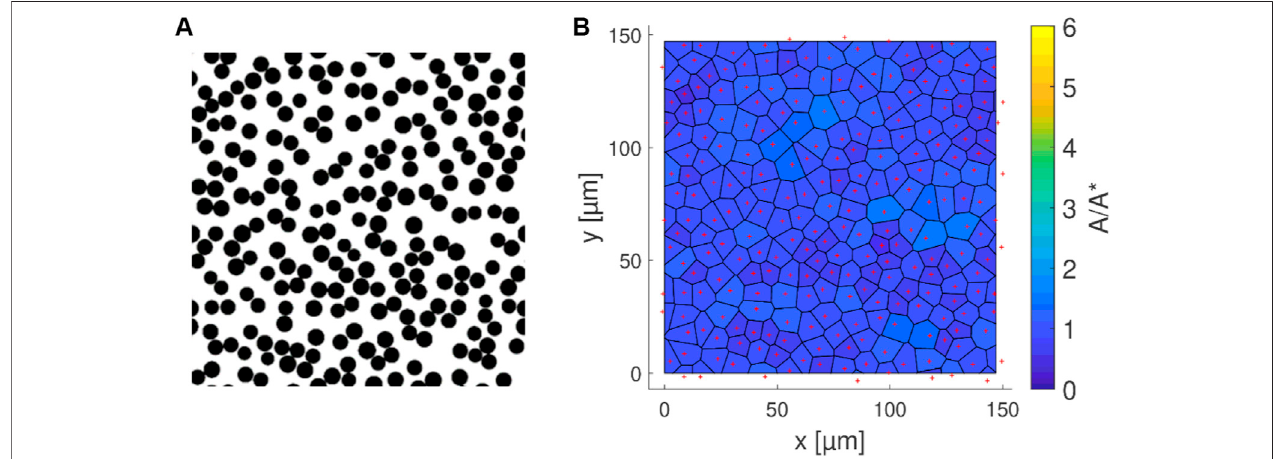
FIGURE 7 | Example of an SVE with 40% fi ber volume fraction; (A) fi ber distribution; (B) Voronoi polygon areas.